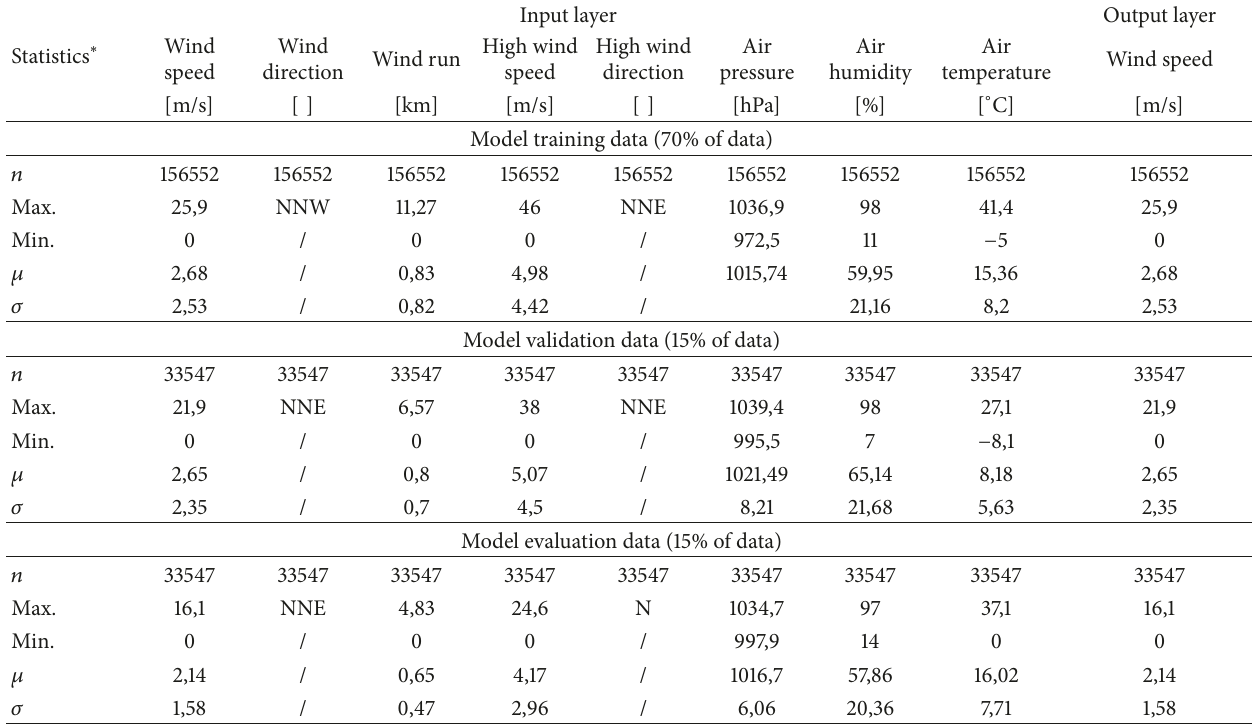
Table 1: Statistics of data used for training, validation, and evaluation of the ANN wind prediction model.